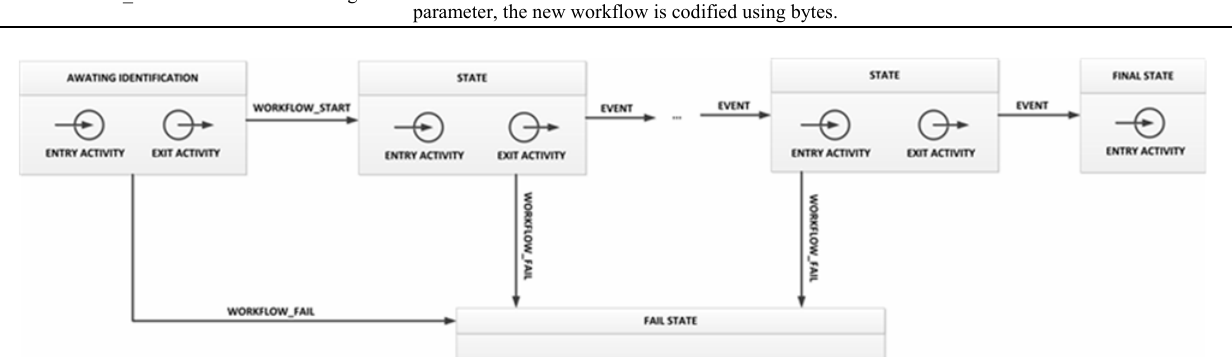
Figure 12. General workflow format in the TF4SM-based